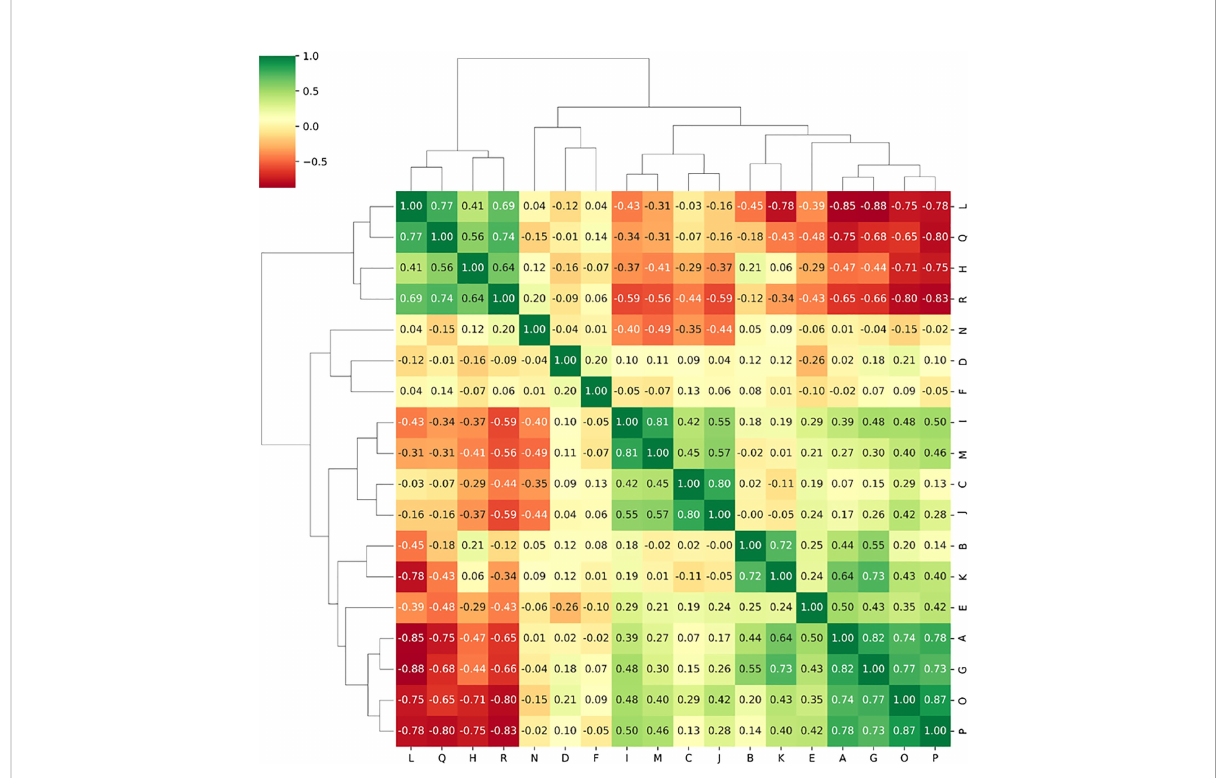
FIGURE 4 The Spearman correlation coef fi cients between radiomics features selected from T2WI